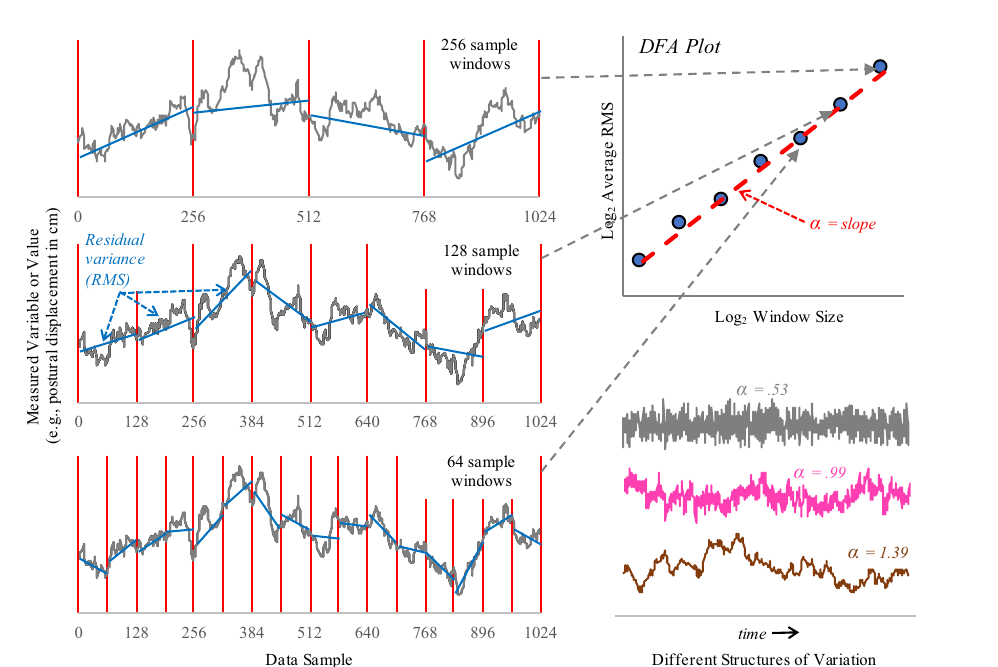
Fig. 1 Illustration of detrended fl uctuation analysis (DFA). DFA determines the degree of random or persistent (deterministic) structure within a stochastic motion time-series from the slope, α (alpha), of a log-log plot of the average residual variance (root-mean-square; RMS) as a function of changing the window size used to calculated residual variance estimates. The bottom right time-series provide representative examples of white (random), pink (long-range correlated or slightly persistent), and brown (highly persistent) structures of variability. See text for more